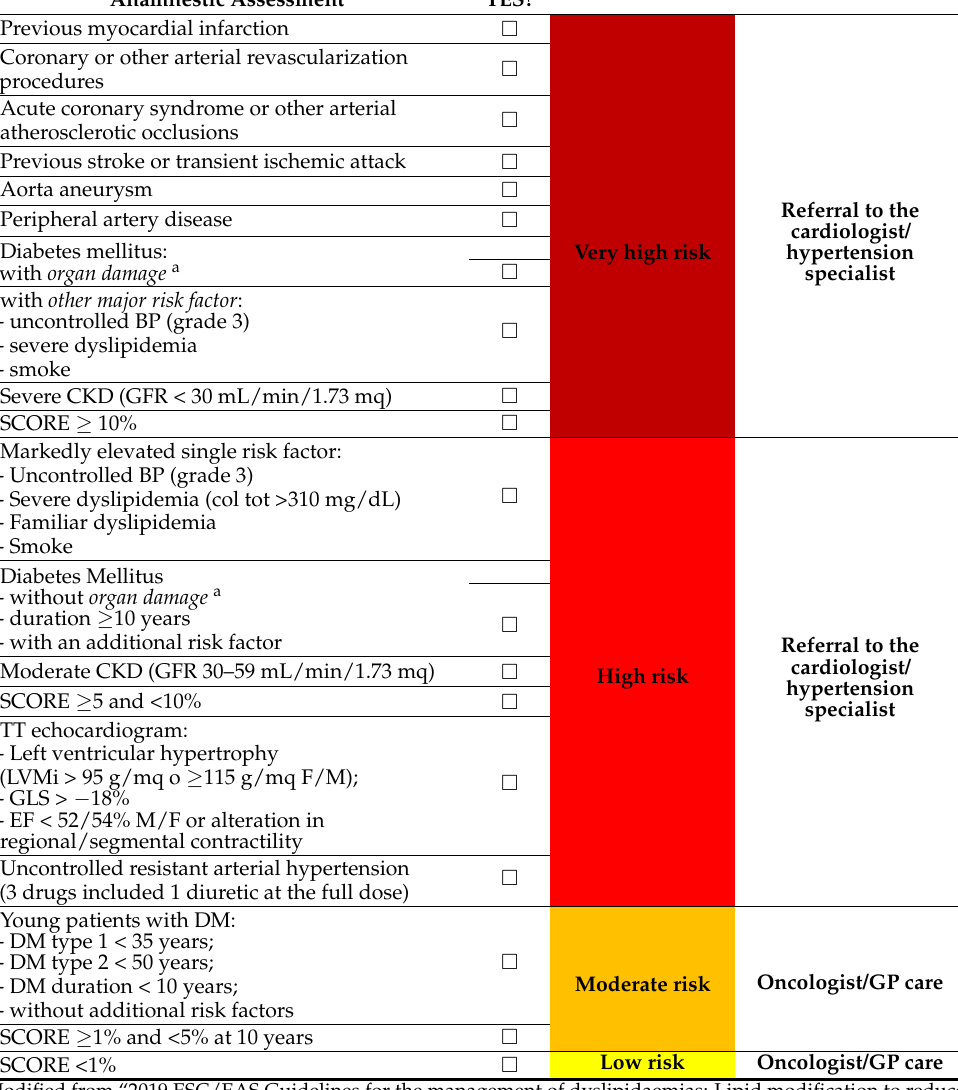
Table 2. Checklist for CV risk scoring for cancer patients with indications of cardiotoxic treatment. Anamnestic Assessment YES? Previous myocardial